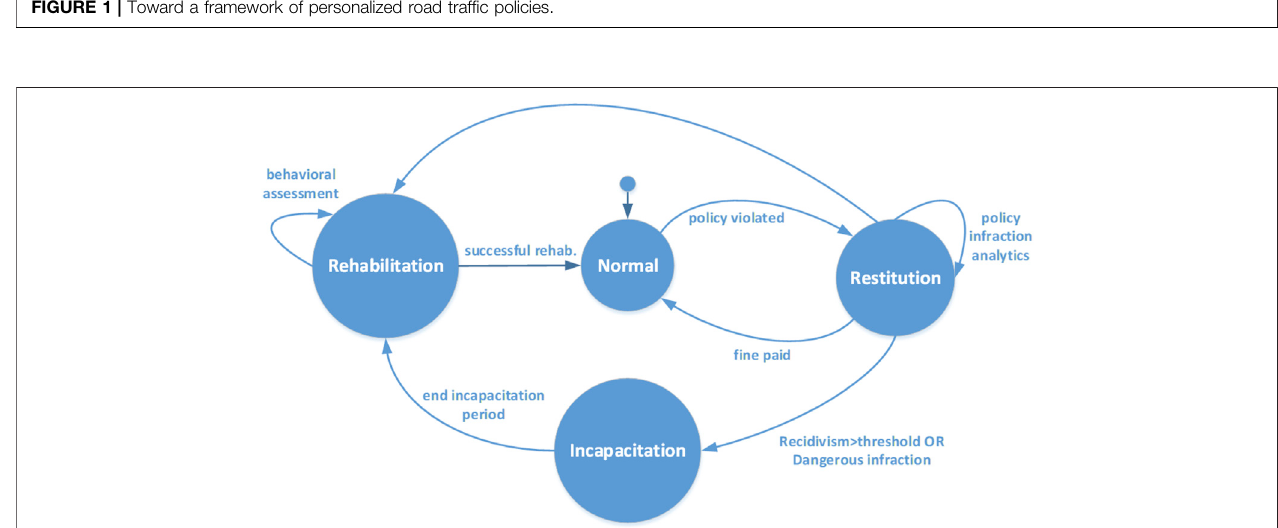
FIGURE 2 | Driving states with respect to road traf fi c